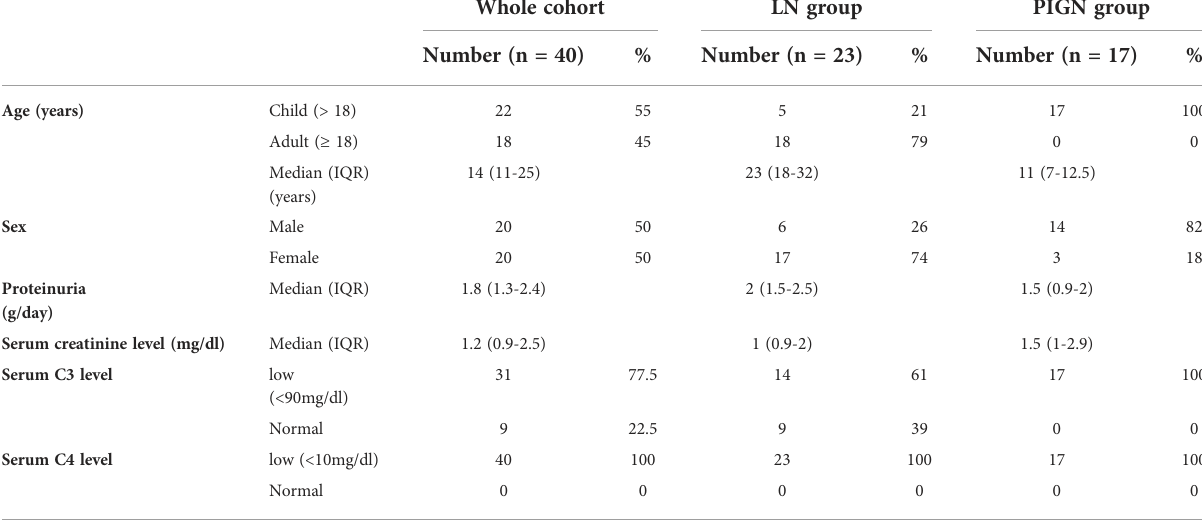
TABLE 1 Summary of the clinical characteristics and laboratory investigations of the 40 studied